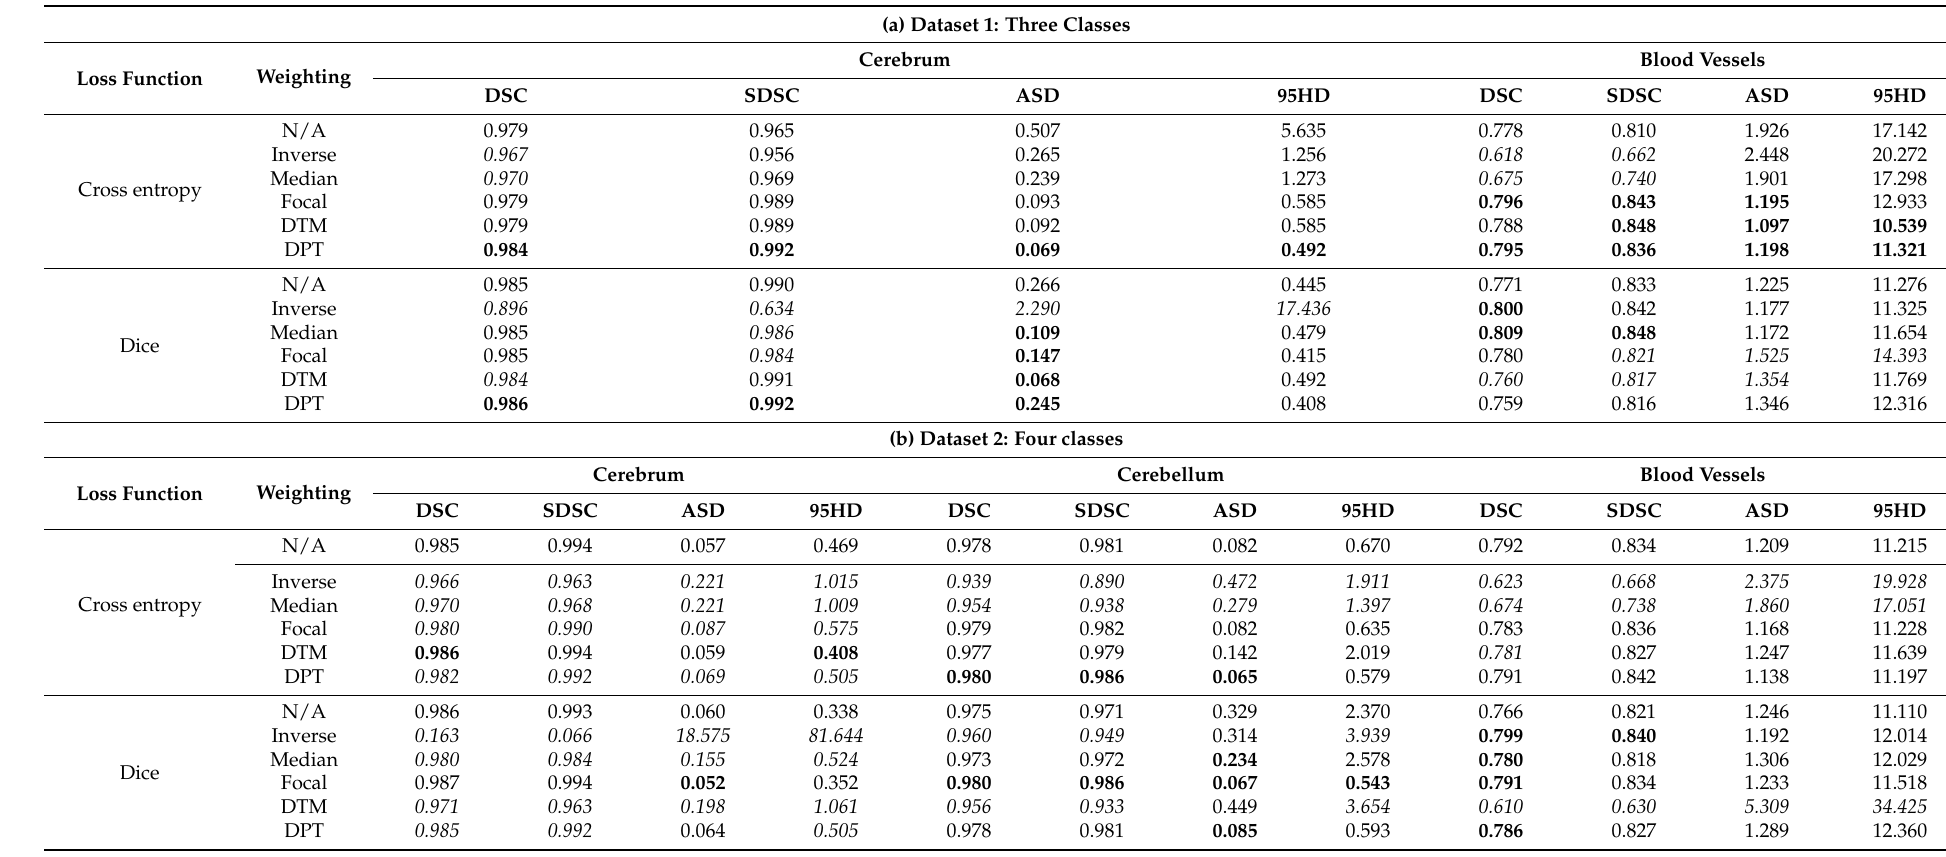
Table 5. Segmentation results of no weighting (N/A), inverse frequency weighting (Inverse), inverse median frequency weighting (Median), focal weighting (Focal), distance transform map-based weighting (DTM), and distance penalty term-based weighting (DPT) in the multi-class segmentation tasks: Dice similarity coefficient (DSC), surface DSC (SDSC), average symmetric surface distance (ASD), and 95th-percentile Hausdorff distance (95HD). (a) Dataset 1: three classes, (b) Dataset 2: four classes, and (c) Dataset 3: five classes. The results of background class are excluded in this table. Compared with the results of N/A, the significantly better and worse results are shown in bold and italic, respectively (Wilcoxon signed-rank test, p < 0.05, not adjusted for